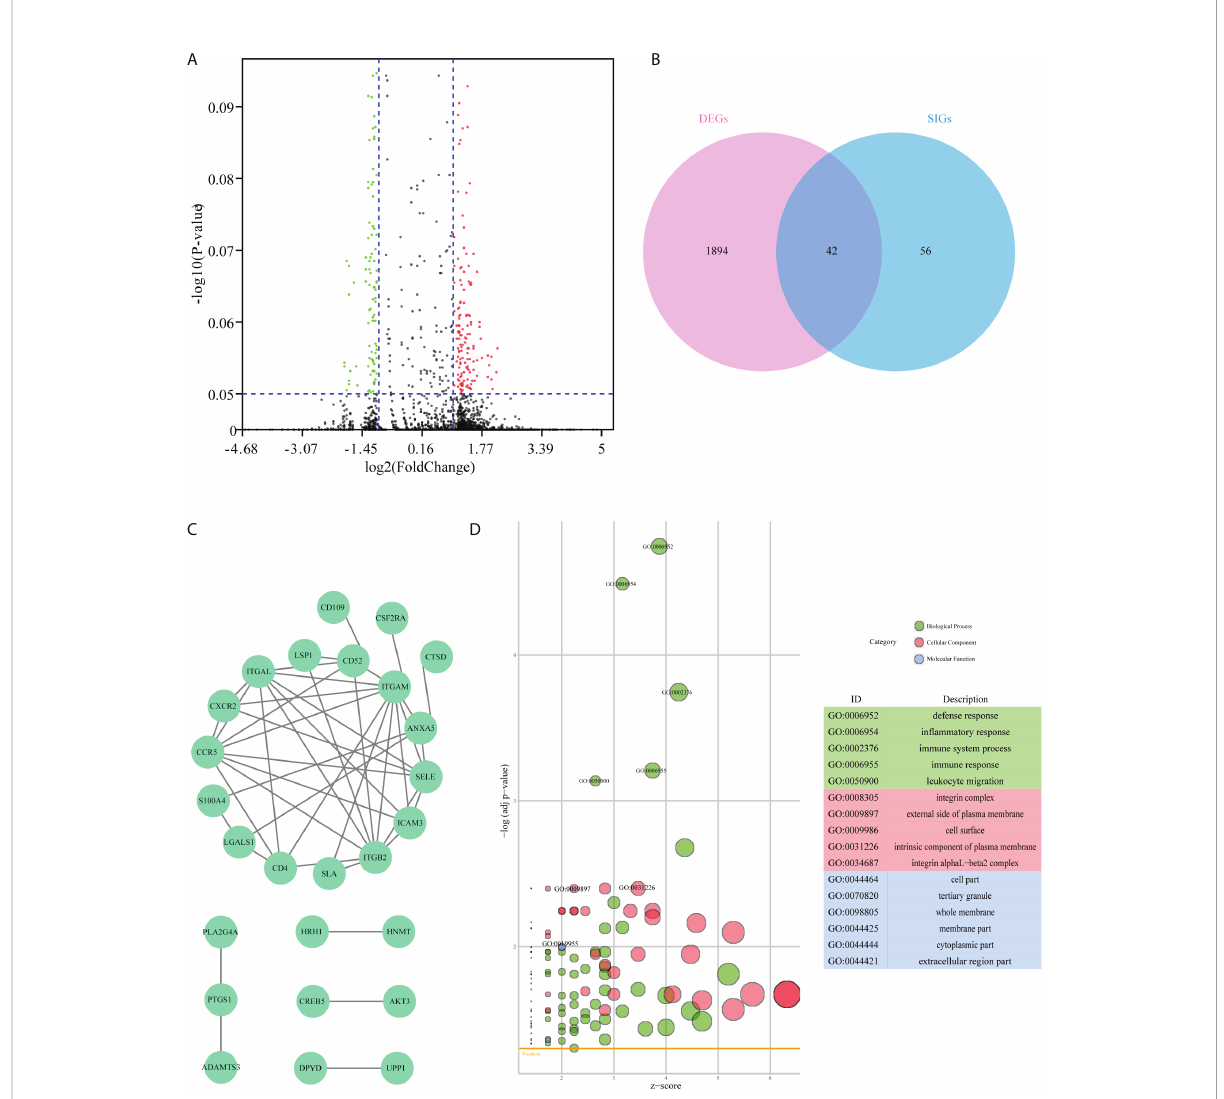
FIGURE 3 Difference analysis of the mRNA expression dataset from TCGA-AML patients. (A) Volcano plot of differentially expressed genes between immune in fi ltration-lacking subtype (IL type) and immune in fi ltration-rich subtype (IR type). (B) Venn plot of the intersecting genes between differentially expressed genes (DEGs) and survival-related immune genes (SIGs). (C) PPI network of 42 overlap genes DEG-SIGs. (D) The bubble plot represents the GO functional enrichment analysis of 42